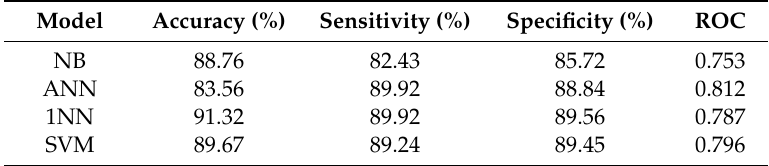
Table 7. Performance comparison matrix (4 × 4) of four classifiers.